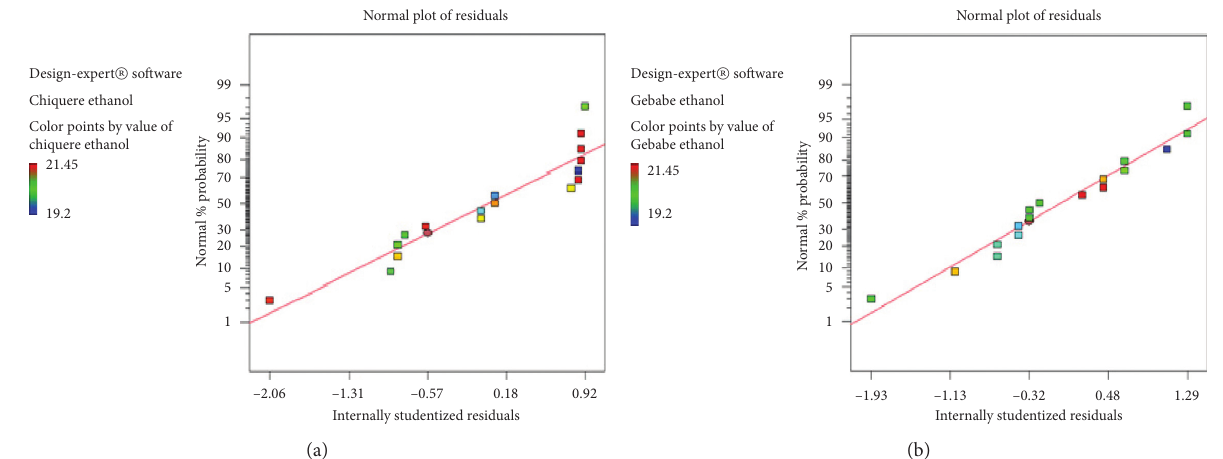
Figure 2: Normal plot of residuals for ethanol production from Chiquere and Gebabe varieties of sweet sorghum. (a) Chiquere variety; (b) Gebabe variety.